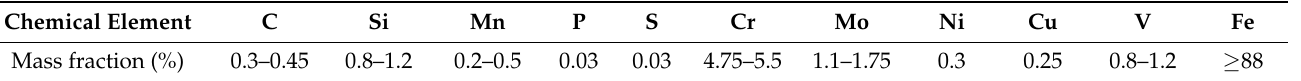
Table 1. Chemical composition of SKD61 die